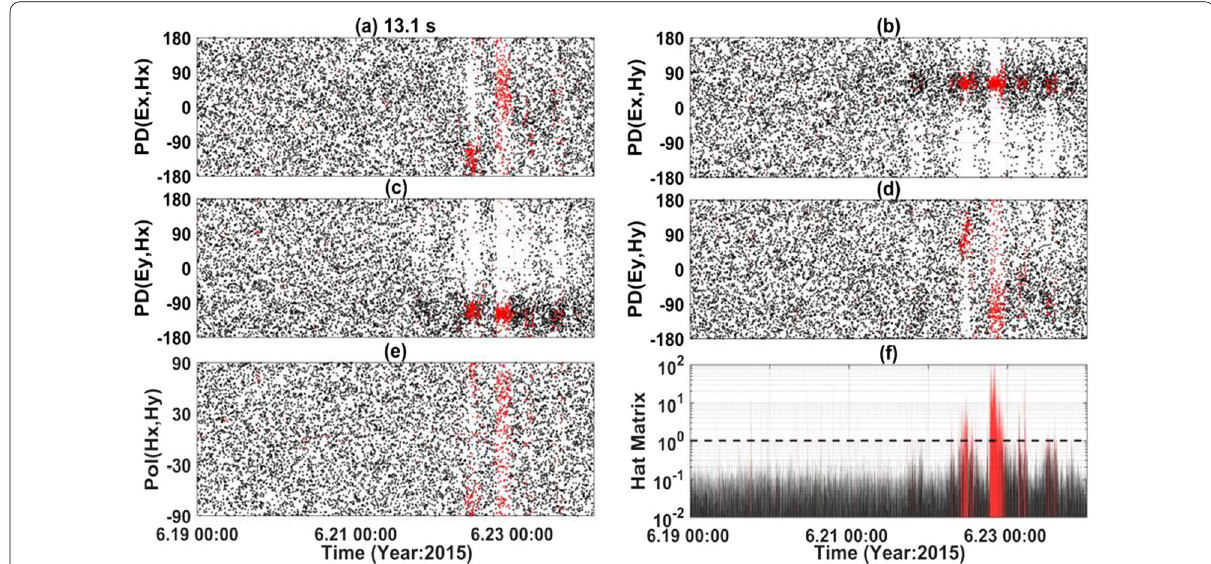
Fig. 14 Evaluation indices in the period of 13.1 s using the data observed from June 19 to June 24 at site TNV48. The data in red correspond to the leverage data associated with the storm. There are preferred directions of the PD corresponding to the leverage data, as shown in b and c